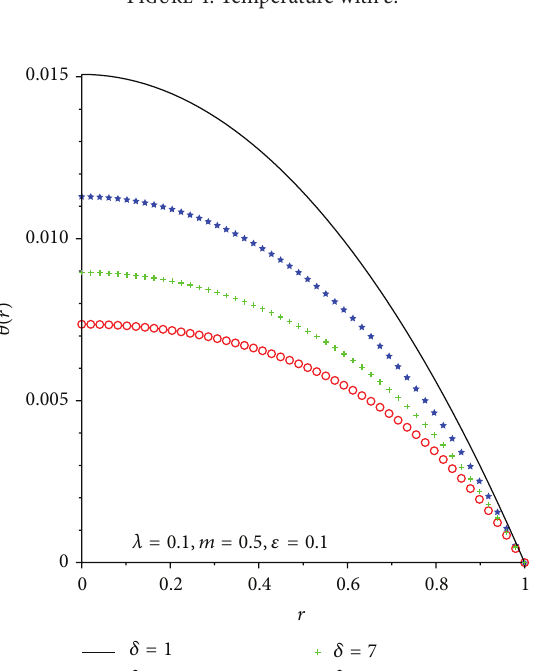
Figure 4: Temperature with 𝜀 .